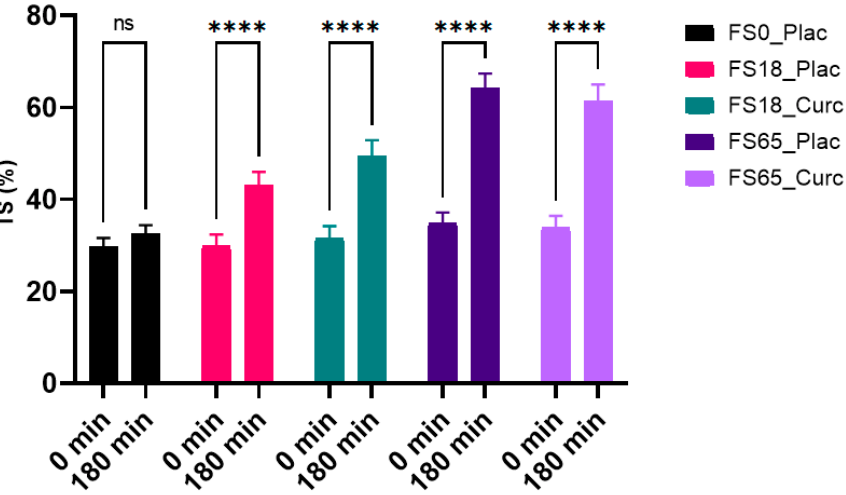
Figure 5. Effect of 180 min supplementation on mean serum transferrin saturation (TS) % (mean, SEM). * represents sig- nificance values when comparing time points within the same the conditions (**** p < 0.0001); ns represents no significant difference ( p > 0.05).